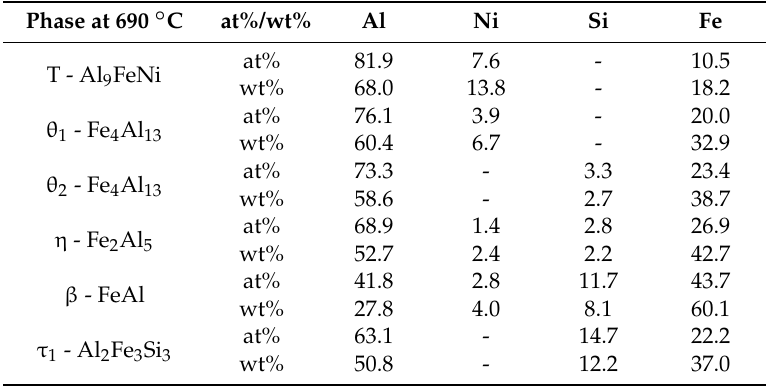
Table 5. Equilibrium concentration of phases at 690 ◦ C calculated using Thermo-Calc TM